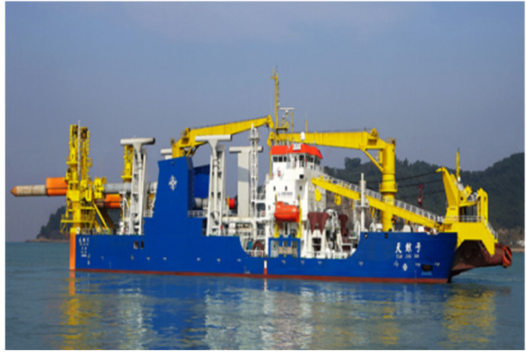
Figure 1. Suction dredger.